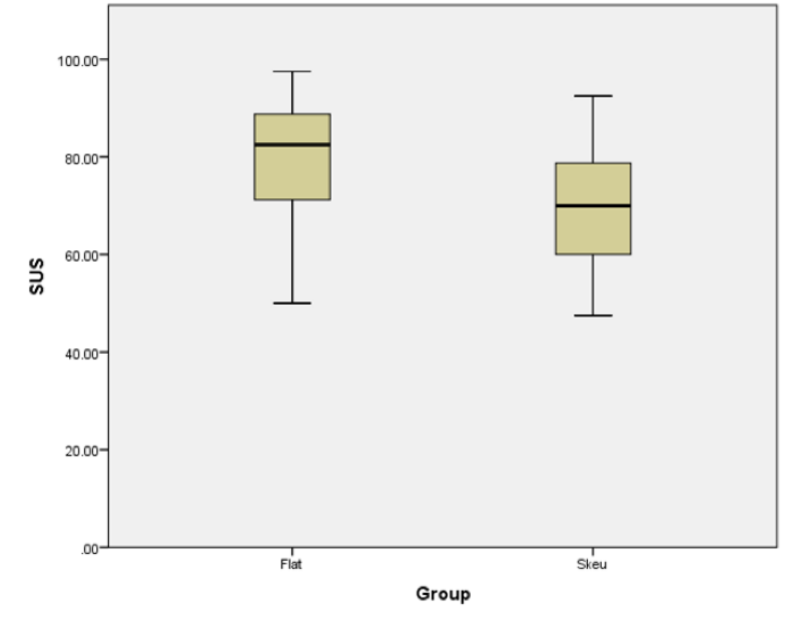
Figure 10. A summary of the results of the SUS questionnaires for each